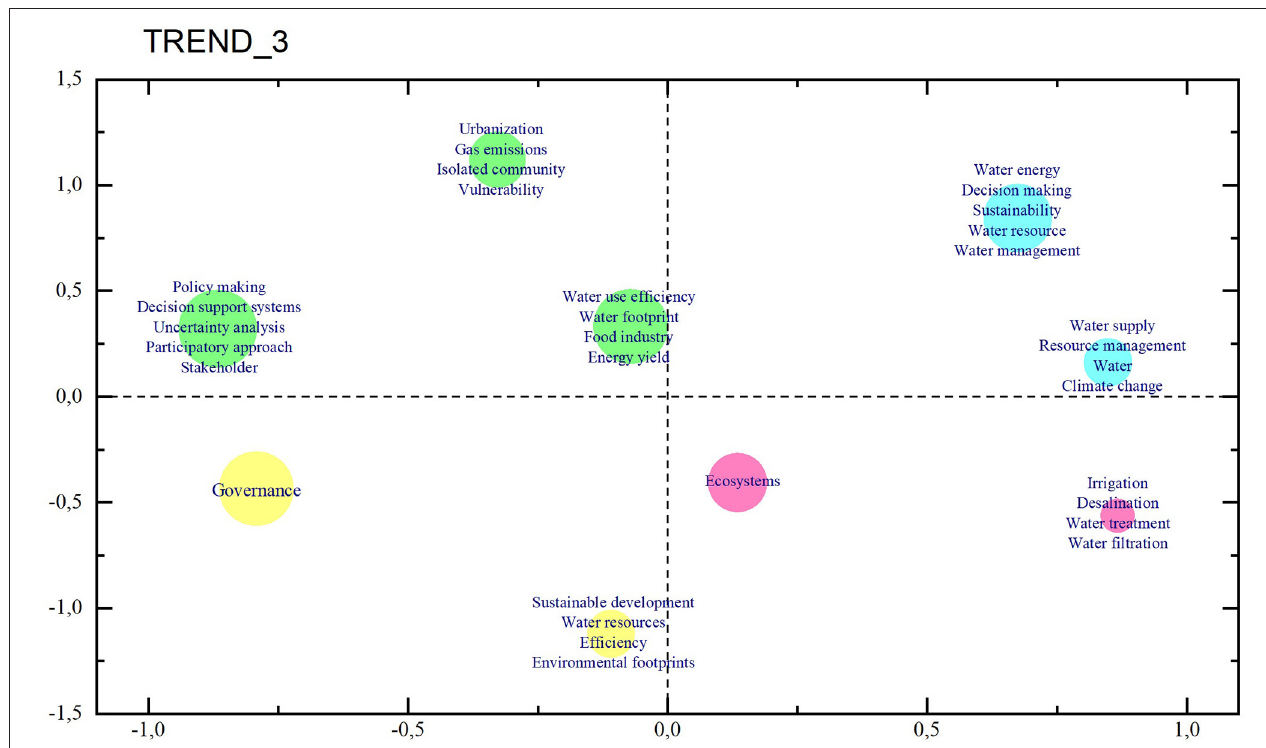
FIGURE 6 | Trend 3 key topics on WEF nexus research in the period